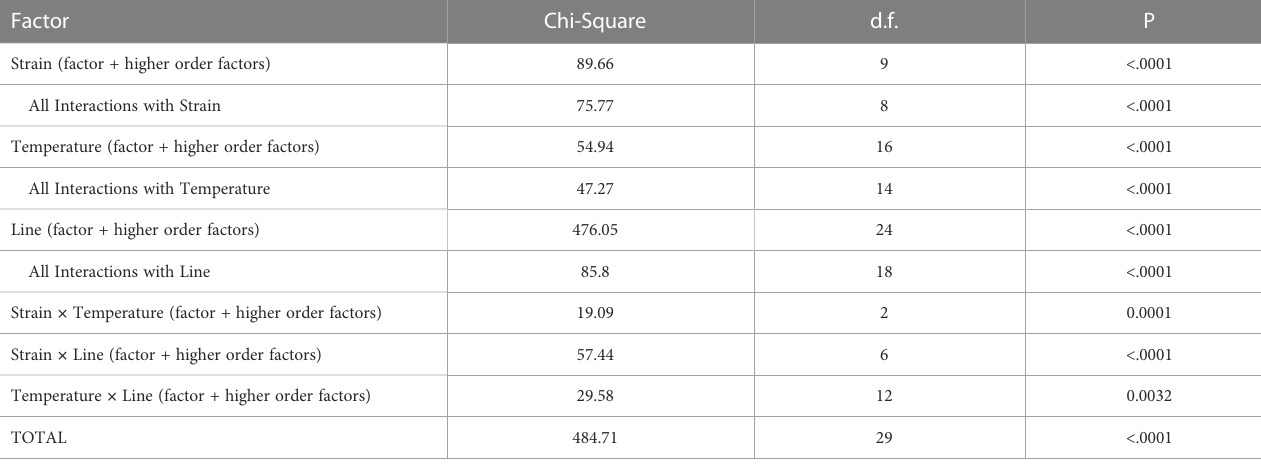
TABLE 1 Analysis of deviance of proportional-odds model for Maximum Symptom Score (MSS). Factor